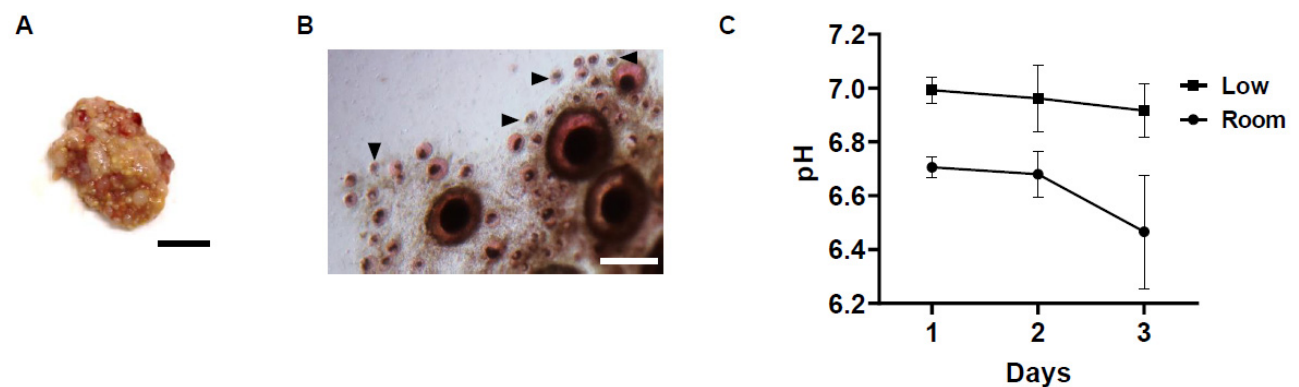
Figure 1. Photograph of average hen ovary utilized for this study, ovarian tissues stained with NR and changes in the pH value of the ovary storage medium. ( A ) Photograph of hen ovary for examination. Bar = 1 cm. ( B ) Representative photomicrograph of chicken ovarian tissue (stored for 2 days at low temperature) stained with NR after enzyme treatment. Most follicles were stained with NR, considered as viable. Arrowheads depict uncoloured follicles, considered as dead. Bar = 1 mm. ( C ) Mean pH ( ± SEM) changes of media in which the ovaries were stored under different conditions (low temperature, room temperature for 1 to 3